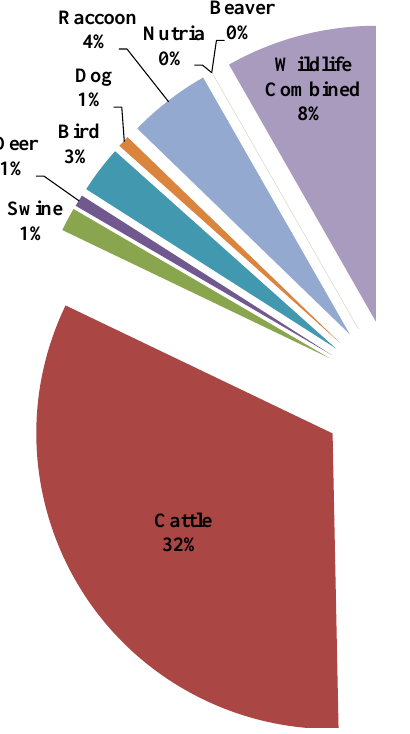
Figure 3. Host source identification of E. coli isolates (n = 144) from the Six Runs Creek sampling site below the